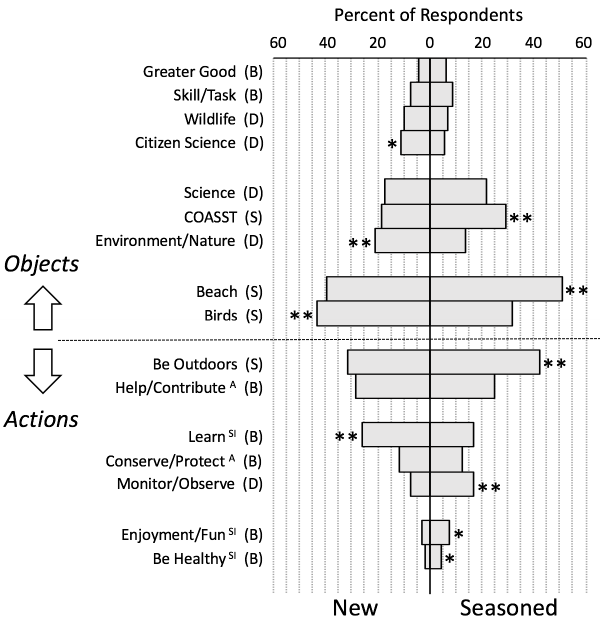
Fig. 2 . The percent of survey respondents expressing objects (top) and actions (bottom) of interest. Participant populations (new, seasoned) as in Figure 1. All objects and actions are categorized as falling into one of three functional types: basic (B), domain-specific (D), or situational (S). Actions relevant to self-interest or altruism are signified by superscripts SI and A, respectively. Asterisks indicate the level of significance for chi- square contingency table tests (new vs. seasoned): *p < 0.05; ** p < 0.01. See text for sample sizes and Appendix 1 for question wording. COASST, Coastal Observation and Seabird Survey